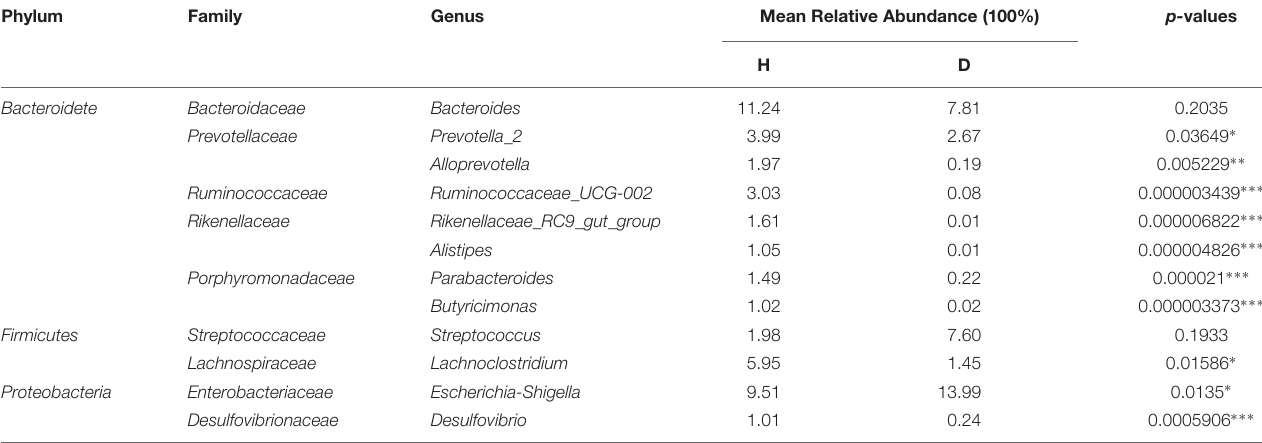
TABLE 1 | Comparisons of 12 core genera between healthy (H) and diarrhea (D) groups. Phylum Family Genus Mean Relative Abundance (100%) p- values